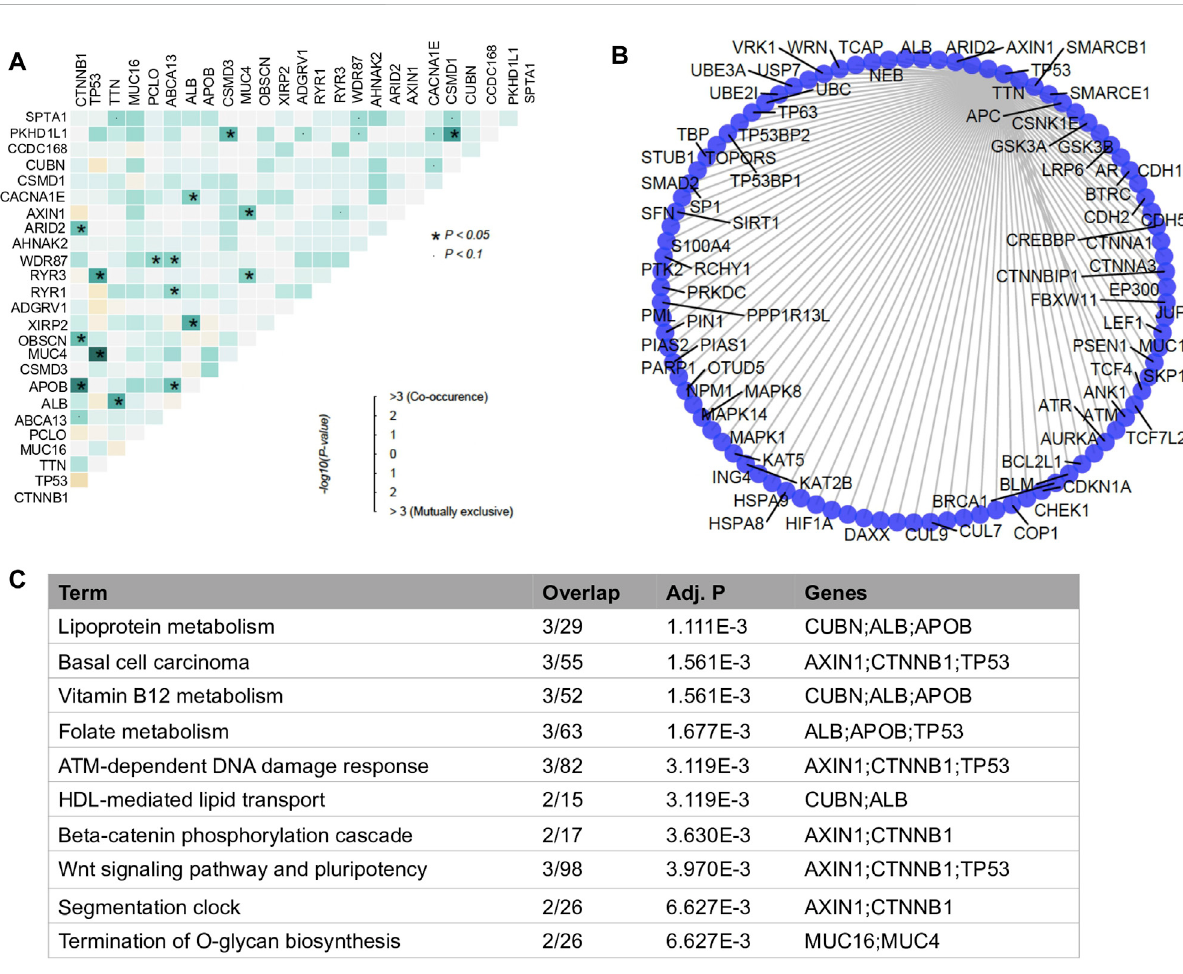
FIGURE 2 Analysis of co-mutated genes. (A) mutational co-occurrence in HCC. The color scale in grids represents the signi fi cance degree of the interaction of two genes. The darker the more signi fi cant. The dark blue square with asterisk represents the p -value of co-mutated gene pair is less than 0.05 and the light blue square with dot represents the p -value of co-mutated gene pair is less than 0.1. (B) Bar plot of enriched biological processes with − log10p > 1bydatabasesofReactomebetweenvariantandnon-variant HCCs. (C) Functionallyenrichedbiologicalprocesses of the co-mutated